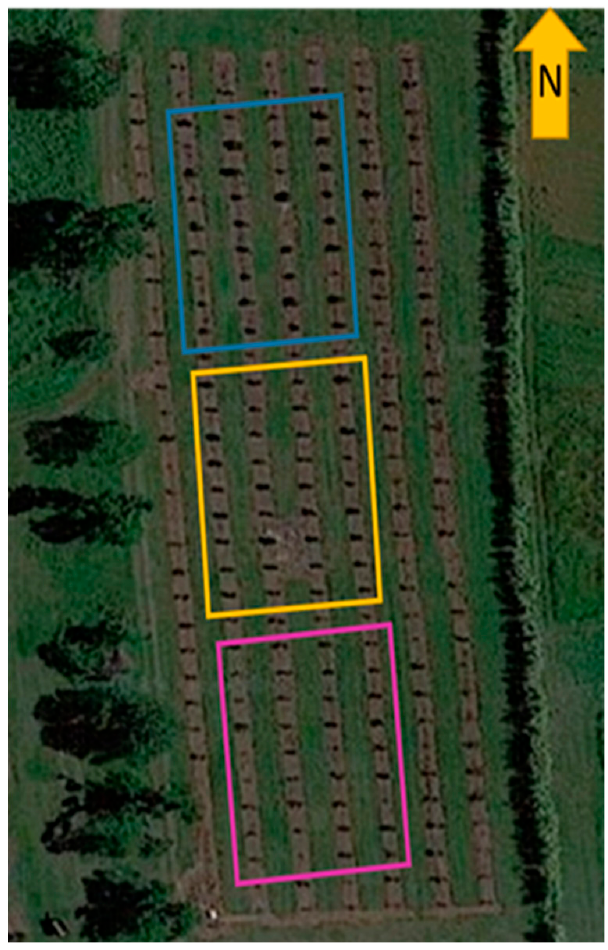
Figure 1. View of the experimental orchard established in the Agricultural Experiment Substation of Isabela. The blue rectangle represents ‘Mexican’ lime orchard, the yellow rectangle is planted with ‘Fina’ clementine mandarin, and the pink rectangle represents ‘Campbell’ Valencia orange. Border trees are ‘Rhode red’ Valencia orange grafted in ‘Swingle’ citrumelo.